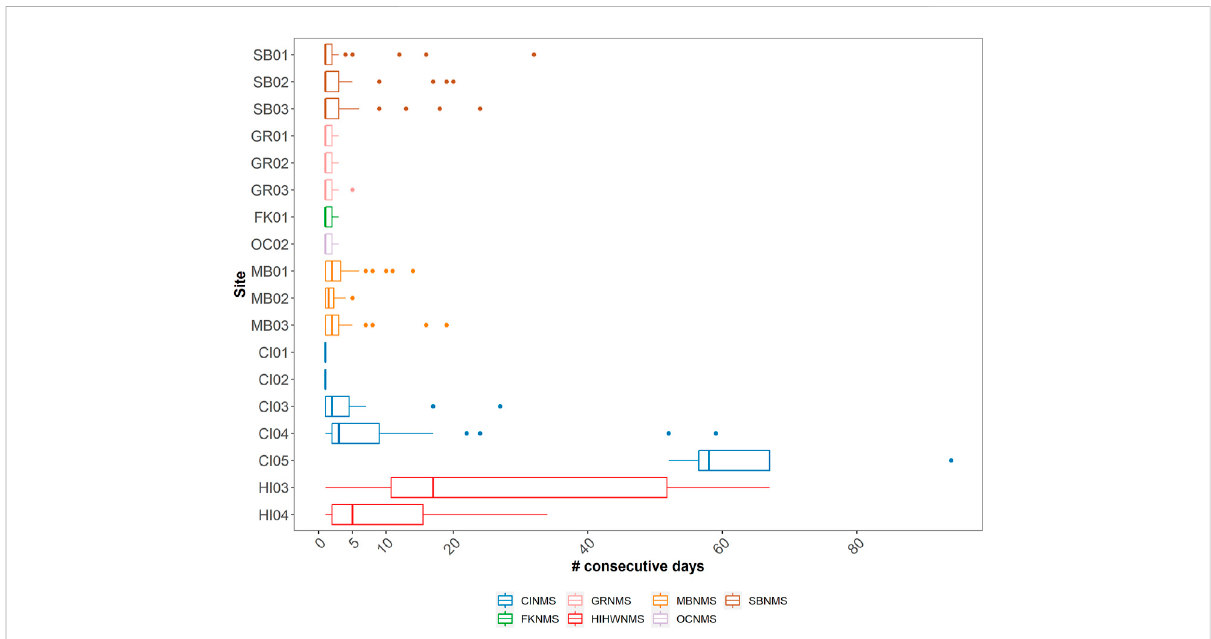
FIGURE 7 Aboxplotshowingthemedianandquartilevaluesofthenumberofconsecutivedaysdelphinidwhistleswerepresentacross18passiveacoustic recordingsiteswithinsevenNMS,dividedintothreemainregions:EastCoastRegionUnitedStates(US)-StellwagenBankNationalMarineSanctuary (SBNMS), Gray ’ s Reef National Marine Sanctuary (GRNMS), Florida Keys National Marine Sanctuary (FKNMS); West Coast Region US - Olympic Coast National Marine Sanctuary (OCNMS), Monterey Bay National Marine Sanctuary (MBNMS), Channel Islands National Marine Sanctuary (CINMS) andHawai ʻ iRegionUS-HawaiianIslandsHumpbackWhaleNationalMarineSanctuary(HIHWNMS).FK02isnotshownastherewerenoconsecutive days of delphinid acoustic presence at that